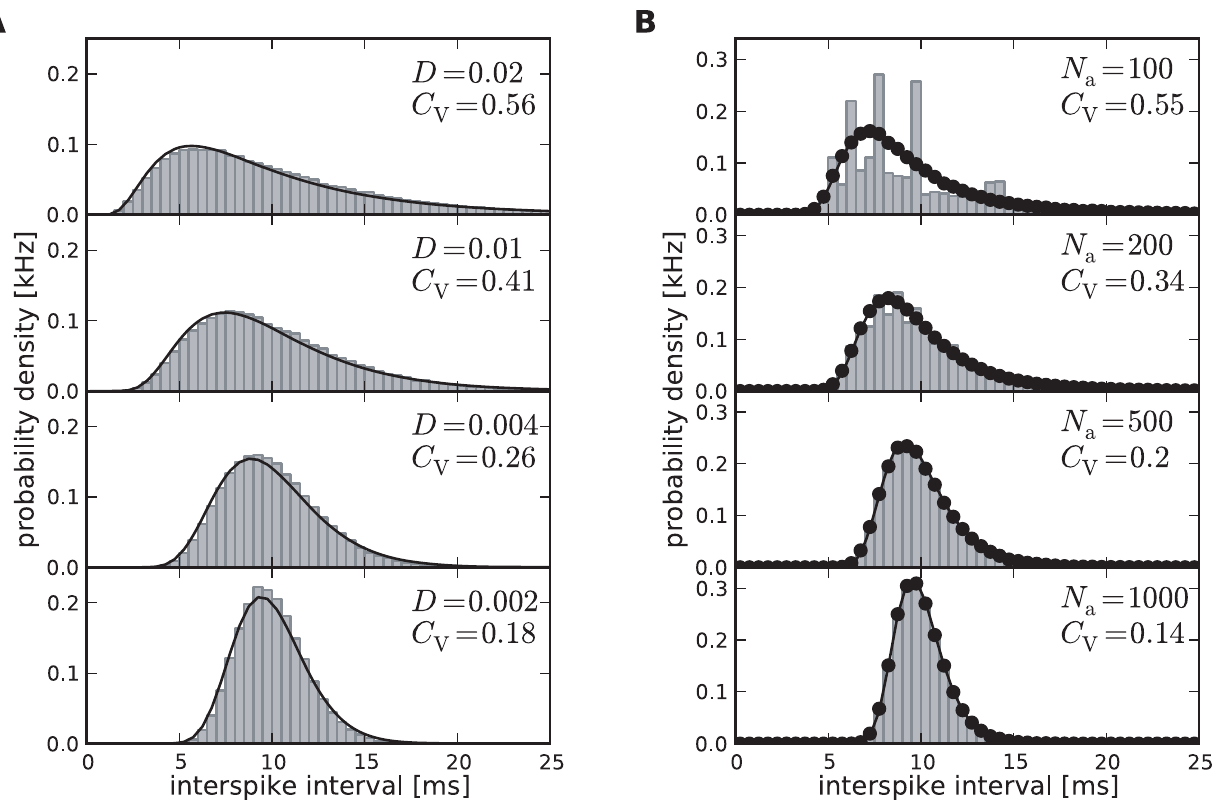
Figure 3. ISI histograms of a PIF neuron – theory vs. simulation. A ISI densities in the case of deterministic adaptation ( N a ? ? ) for different noise intensities D . Gray bars show the histograms obtained from simulations of Eq. (2); solid lines display the mean-adaptation approximation, Eq. (64) (inverse Gaussian density). B ISI densities in the case of stochastic adaptation ( D ~ 0 ) for different N a as indicated in the panels. The adaptation current was modeled either by the channel model (gray bars), Eq. (20), or by the diffusion model (circles), Eq. (1). The theory, Eq. (69), is displayed as a solid line. Parameters are chosen as in Fig. 2.